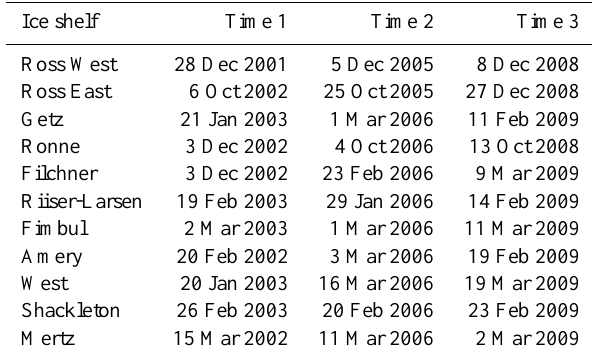
Table 5. MODIS images used for deriving velocities and velocity changes for ten other ice shelves in